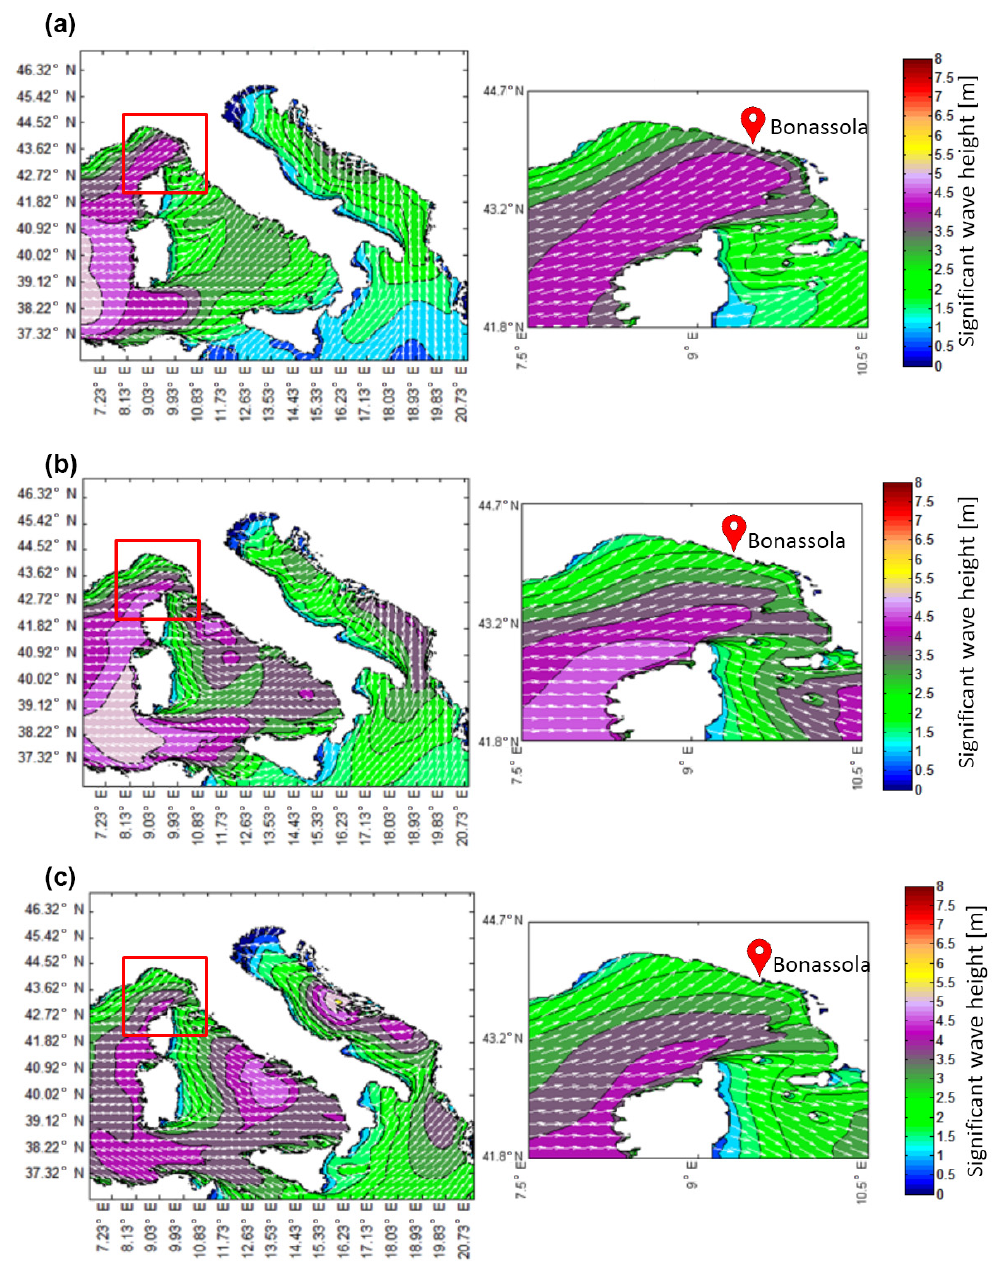
Figure 7. Ligurian Sea significant wave height (colour maps) and direction (vector fields) in three moments of sea storm in February 2016. The maps are relative to the WW3 model simulation on 10 February 2016 at (a) 00:00UTM, (b) 06:00UTM and (c) 12:00UTM. Wave height isolines are at 0.5m